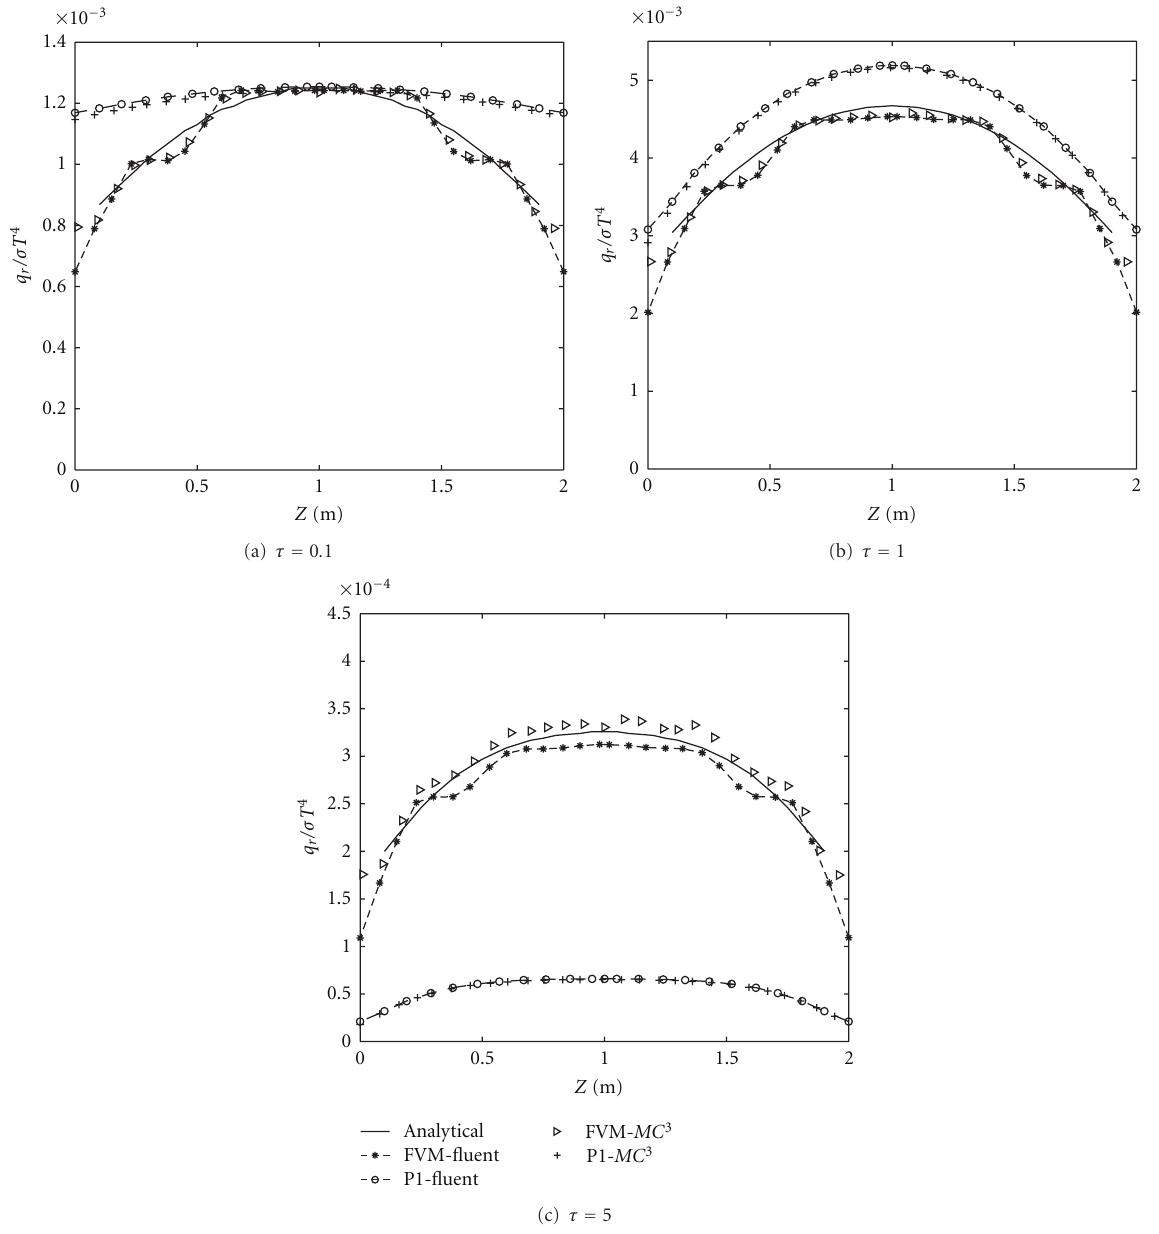
Figure 2: Results for test case